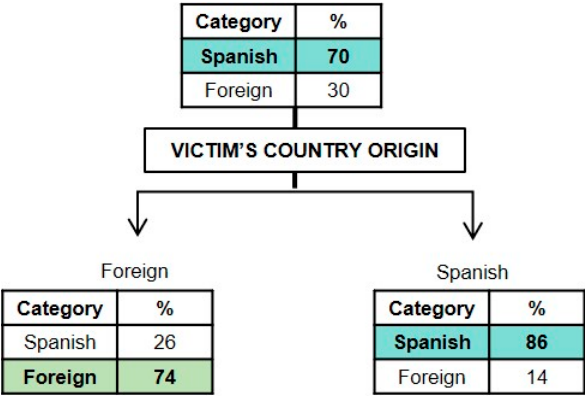
Figure 3. Graphical representation of the classification tree for the perpetrator’s country of origin.